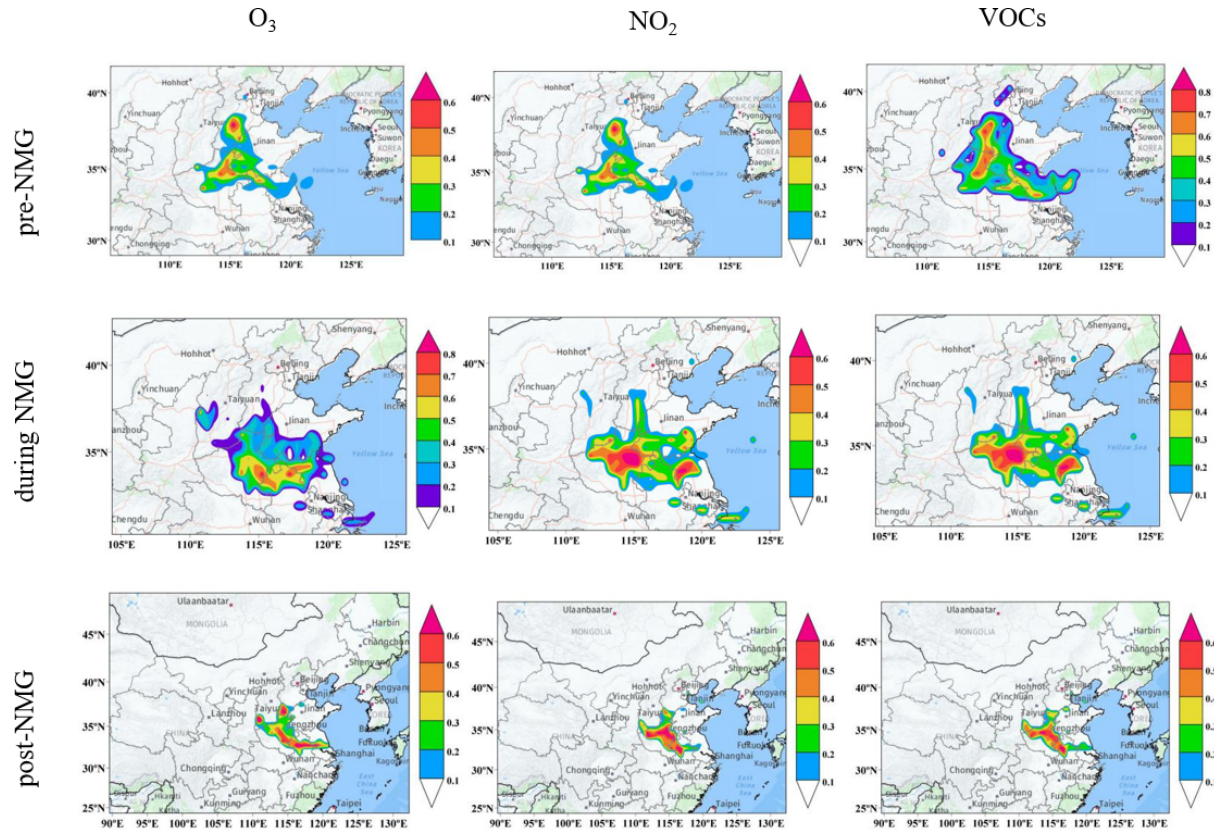
Figure 2. The average weighted PSCF maps for O 3 , NO 2 , and VOCs in Zhengzhou during the three